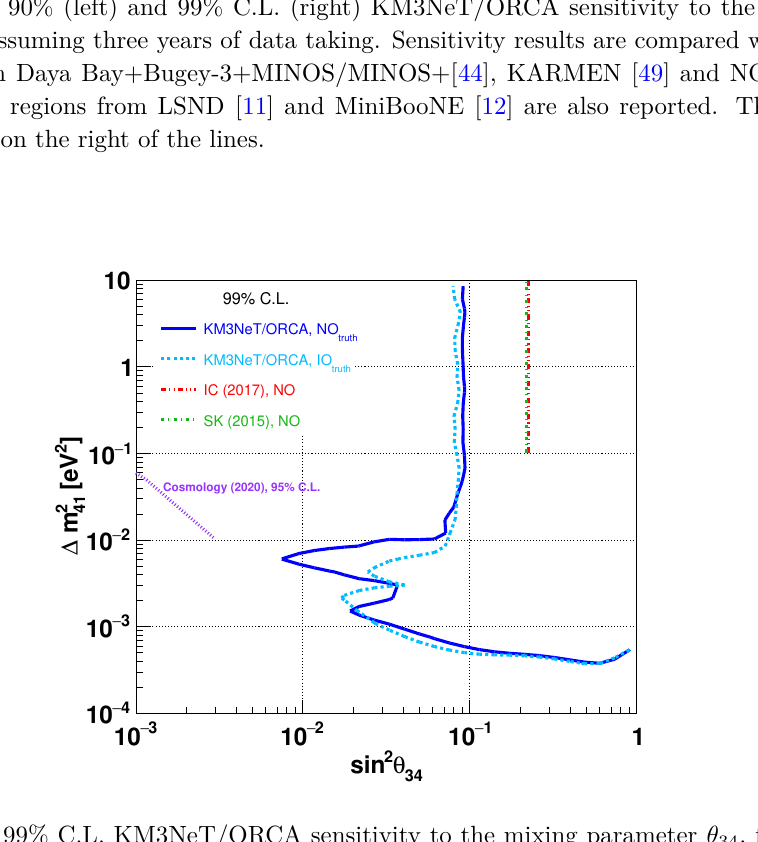
Figure 11 . The 99% C.L. KM3NeT/ORCA sensitivity to the mixing parameter θ 34 , for different values of ∆ m 2 , for three years of data taking. Sensitivity results are compared with current upper 41 limits from cosmology [13], IceCube/DeepCore [39] and SK [42]. The excluded region is the one on the right of the